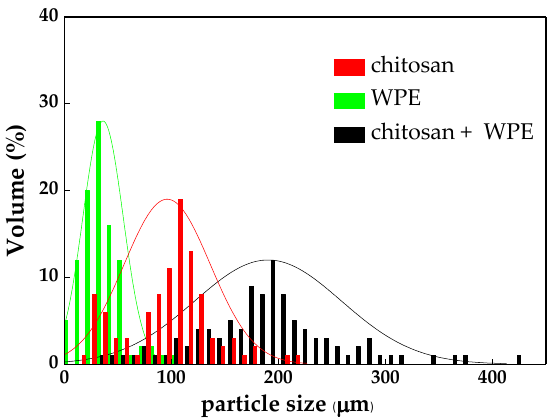
Figure 4. Size distributions of the C. vulgaris flocs with chitosan and WPE.